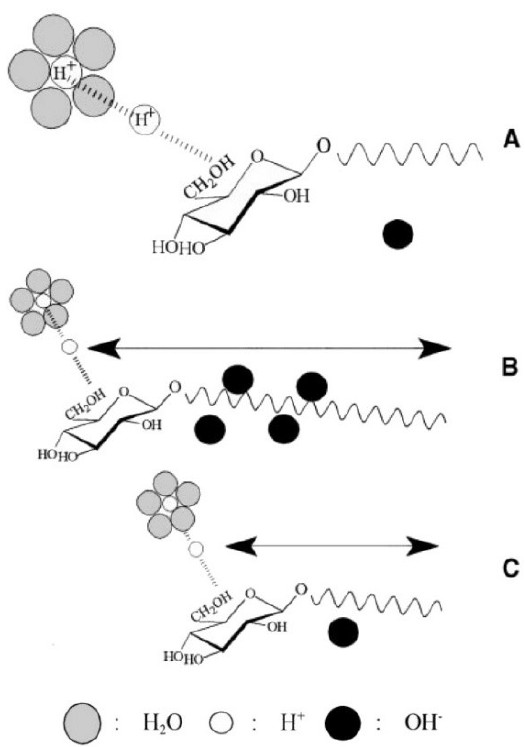
Figure 9. Proposed mechanisms of the air/water interface charging process: ( A ) Repelling of HC ions by OH − groups of AG under acidic pHs, ( B ) enhanced adsorption of OH − ions for highly hydrophobic surfactants, and ( C ) reduced interaction between anions and air/water interface for hydrophilic surfactants. Reprinted from [70]. Copyright (2022), with permission from Elsevier. Calgaroto et al. [179] studied the effect of a commercial alkyl methyl ether monoamine with cationic character and SDS on the zeta potential of NBs. By comparing similar results reported by Najafi et al. [18] and Jia et al. [180], they concluded that in the presence of cationic derivatives from amines, the positive surface charge of NBs reduced the rate of surfactant adsorption up to the isoelectric point (IEP), after which the negative charge was significantly neutralized. Conversely, SDS significantly neutralized the positive surface charge of NBs under acidic conditions where the overall charge of NBs reversed to the negative value. Studies showed that surfactants adsorb at the surface of NBs such that polar heads orient towards the bubble through electrostatic forces and chains rearrange outwards by hydrophobic forces and lead to a change in the zeta potential of NBs, de- pending on the charge of their polar groups [179]. Similarly, Cho et al. [17] showed that the equilibrium state between partially ionized micelles and fully ionized monomers of surfactants can stabilize NBs. Moreover, alkaline conditions may lead to the formation of finer and more stable NBs because highly negatively charged bubbles will repulse each other and prevent inter-bub- ble aggregation and coalescence, as reported by various researchers [20,195,196]. As men- tioned earlier, the repulsion forces among NBs due to their negative surface charge can encourage bubble stability and decrease the rate of bubble coalescence. The zeta potentials of bubbles with different electrolytes, reported by numerous authors, show similarities, and their results are reviewed elsewhere [197]. For example, Uchida et al. [198] showed that a solution containing 100 mM NaCl can improve the stability of O 2 NBs for over a week; however, an excess concentration over an optimal amount may shorten the dura- bility of NBs and accelerate the rate of coalescence. The stabilizing effect of surface charge can also be attributed to the relative arrangement of the water structure at the air/water interface. Bui et al. [117] performed a detailed study on the effect of different chemicals on the average size and zeta potential of NBs. They showed that bubbles in the presence of EDTA (ethylenediaminetetraacetic acid), glucose, and Na + remained nano-sized because of the lower adsorption of possible species at the bubble surface, whereas bubbles in